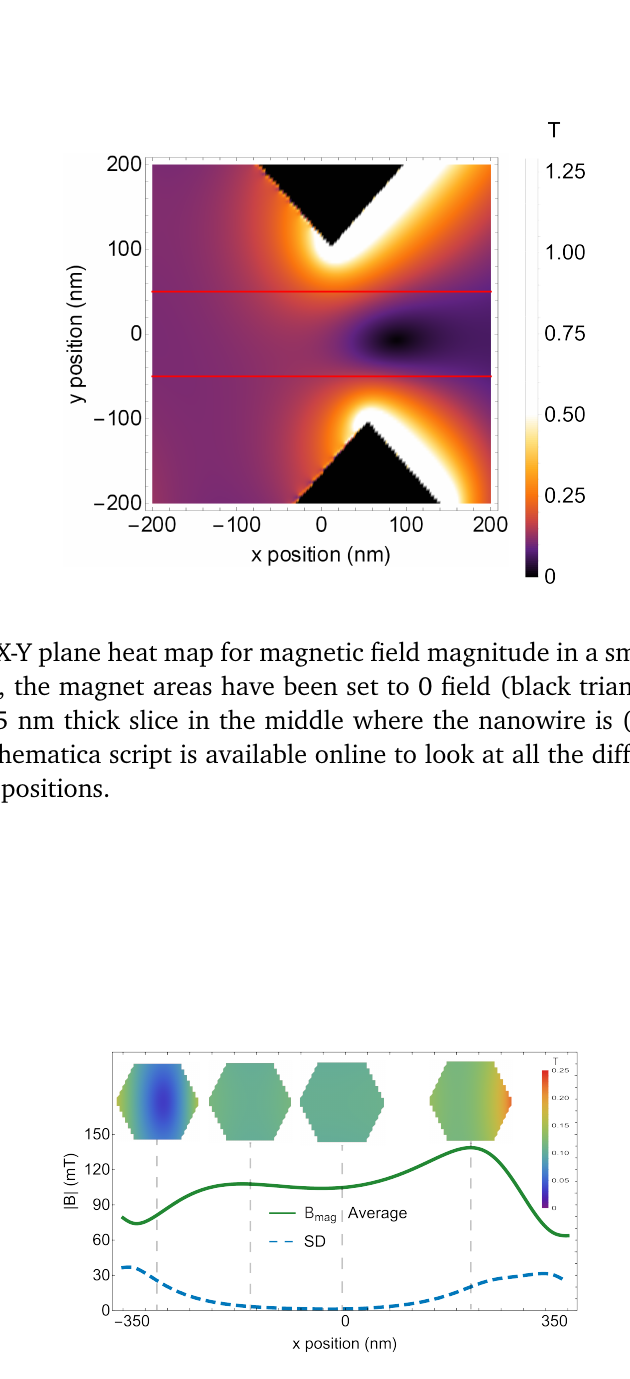
Figure 17: Shows the magnetic field magnitude’s standard deviation (dashed) across the hexagonal cross-section and mean value over the nanowire region for the single Dragonfly set-up. The insets are field magnitude cross sections of the nanowire at different positions. Note the mean value is the same data that is plotted in Fig. 3 (b). A Mathematica script is available on Zenodo to look at all Y-Z slices along the